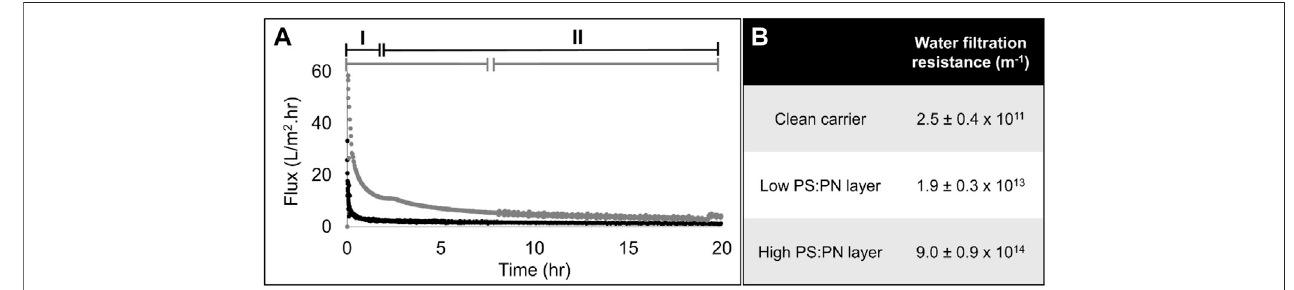
FIGURE 3 | Filtration properties of sEPS gel layer. (A) Flux pro fi les as a function of fi ltration time at constant pressure (0.2 bar) of the sEPS with low PS:PN ratio (anaerobic, grey line) and high PS:PN ratio (aerobic, black line). A formation (I) and operational phase (II) are indicated. The data pro fi le was obtained from the triplicate fi ltration experiment (Replicates are shown in Supplementary Figure S1 ). (B) Final fi ltration resistances of the layers.